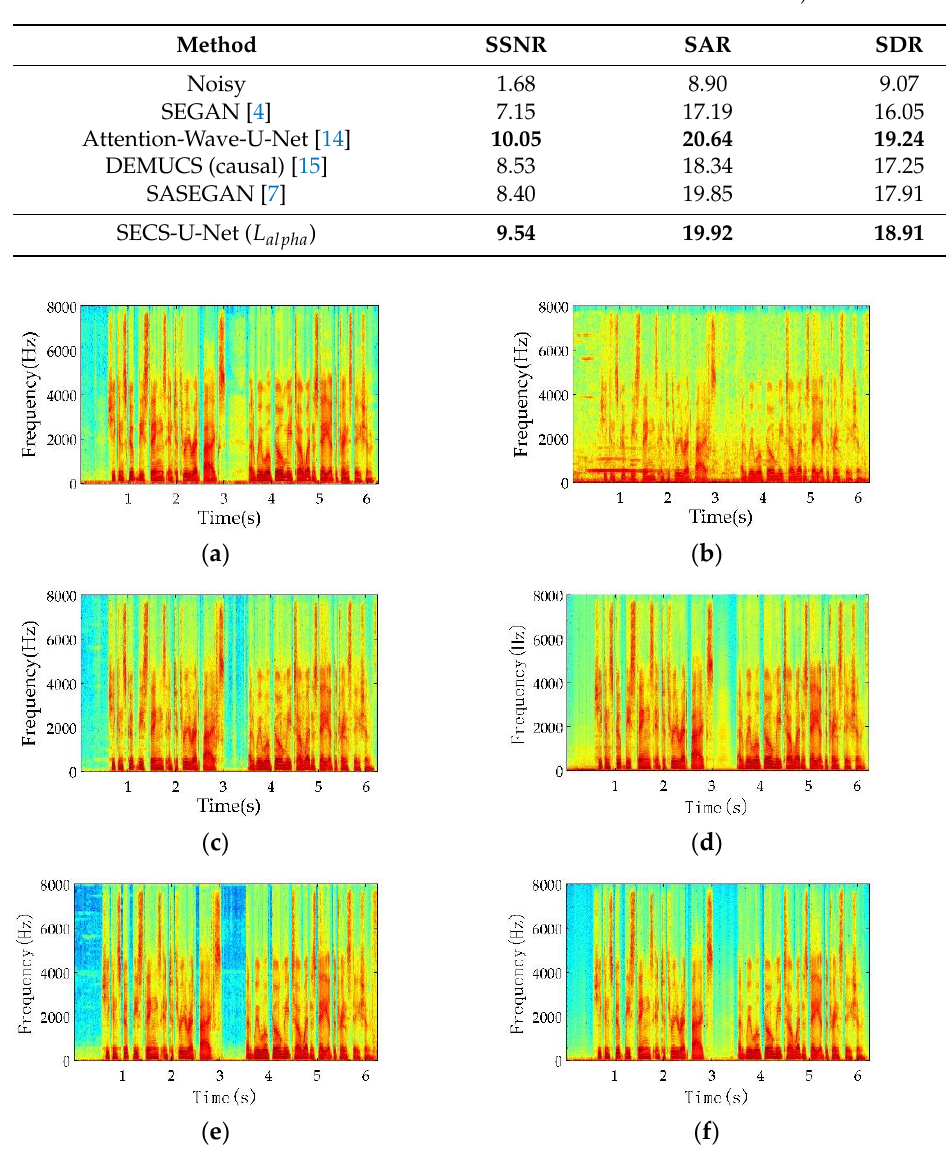
Table 4. SSNR, SAR and SDR of the proposed method and the reference methods (the bold indi- cates our metric scores and the metric scores that exceed ours in the reference models).